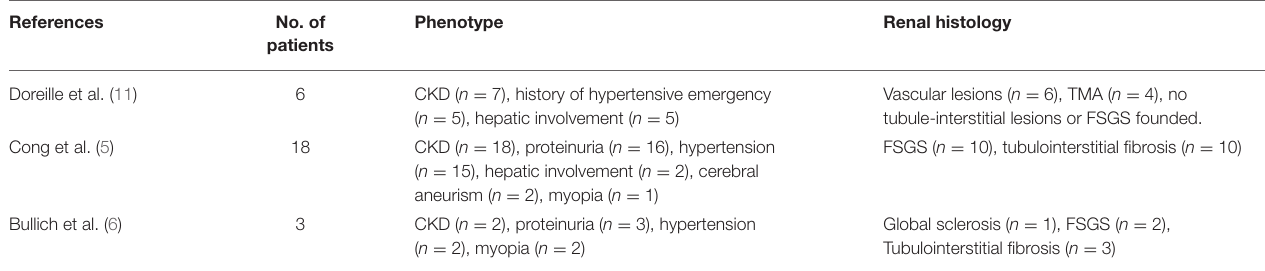
TABLE 1 | Publications reporting cases with TTC21B p209L